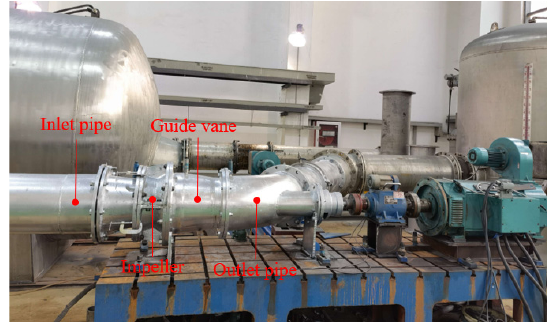
Figure 5. Pump section test.